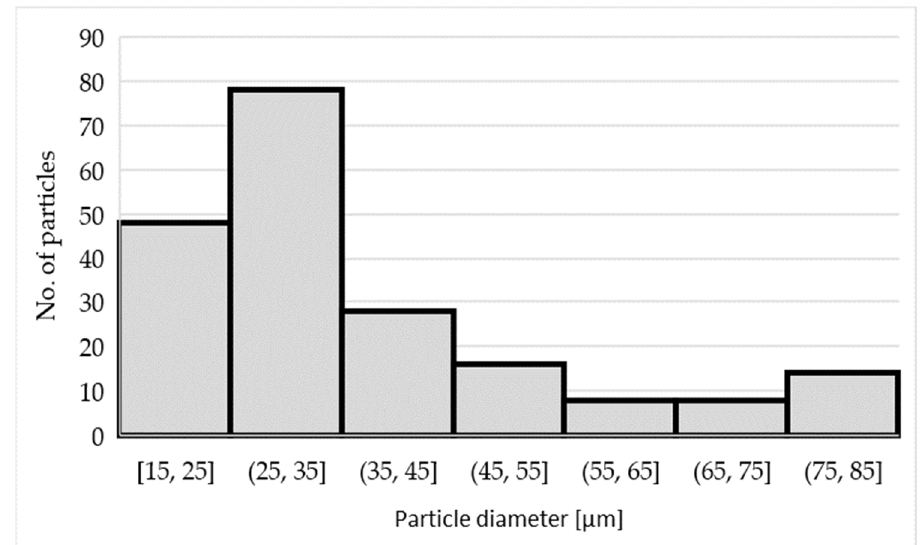
Figure 8. Histogram of the particle size distribution of the TiAl 3 phase in the AlTi5B1 alloy.